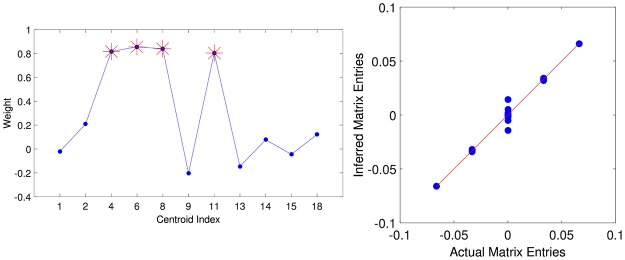
Cluster-aided inference of synaptic couplings for the Hopfield network.Left: Inferred values of the weights ωα when fitting the reduced model (Eq (20)) to the raster plot shown in the lower column of Fig 2). The red stars mark the weights corresponding to the patterns actually stored in the system. Right: Scatter plot of the inferred (reduced model) synaptic couplings against the actual ones. The red curve shows the identity as a reference.